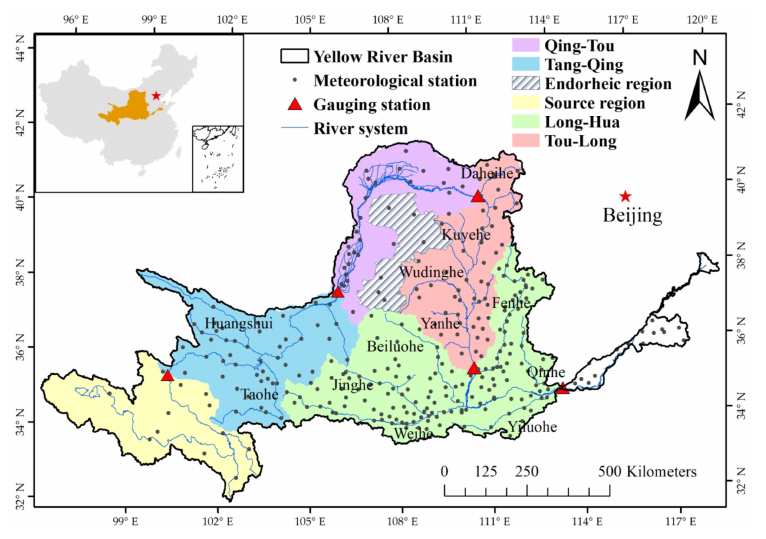
Figure 1. Spatial distribution of the meteorological and streamflow gauge stations in the YRB. Gauge stations are Tangnaihai, Qingtongxia, Toudaoguai, Longmen, and Huayuankou from upstream to downstream